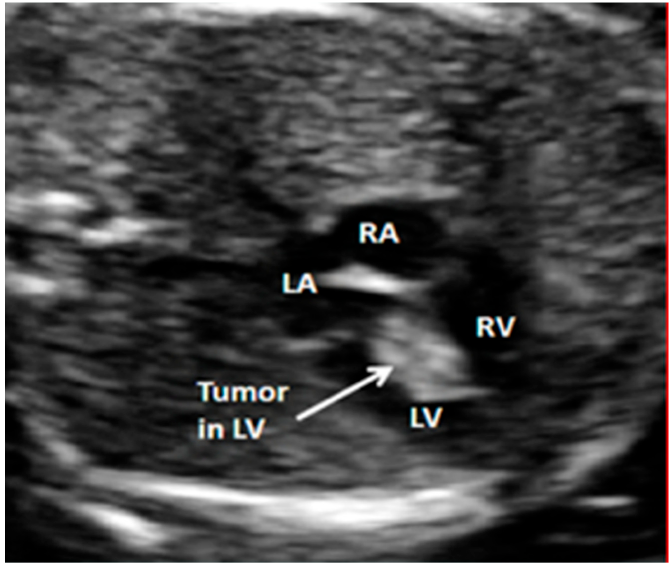
Figure 1. An intracardiac tumor attached to the ventricular septum as observed on four chamber view—LA, left atrium; RA, right atrium; LV, left ventricle; RV, right ventricle. view—LA, left atrium; RA, right atrium; LV, left ventricle; RV, right